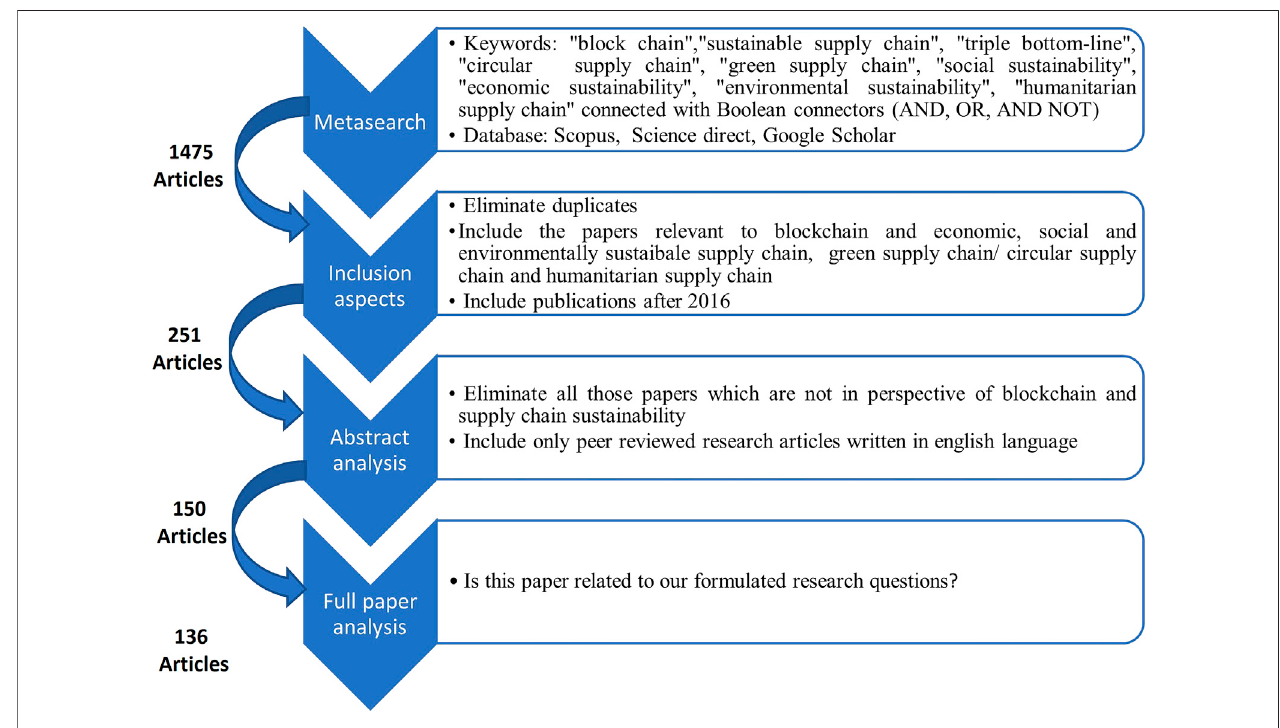
FIGURE 1 | Protocol for the systematic literature